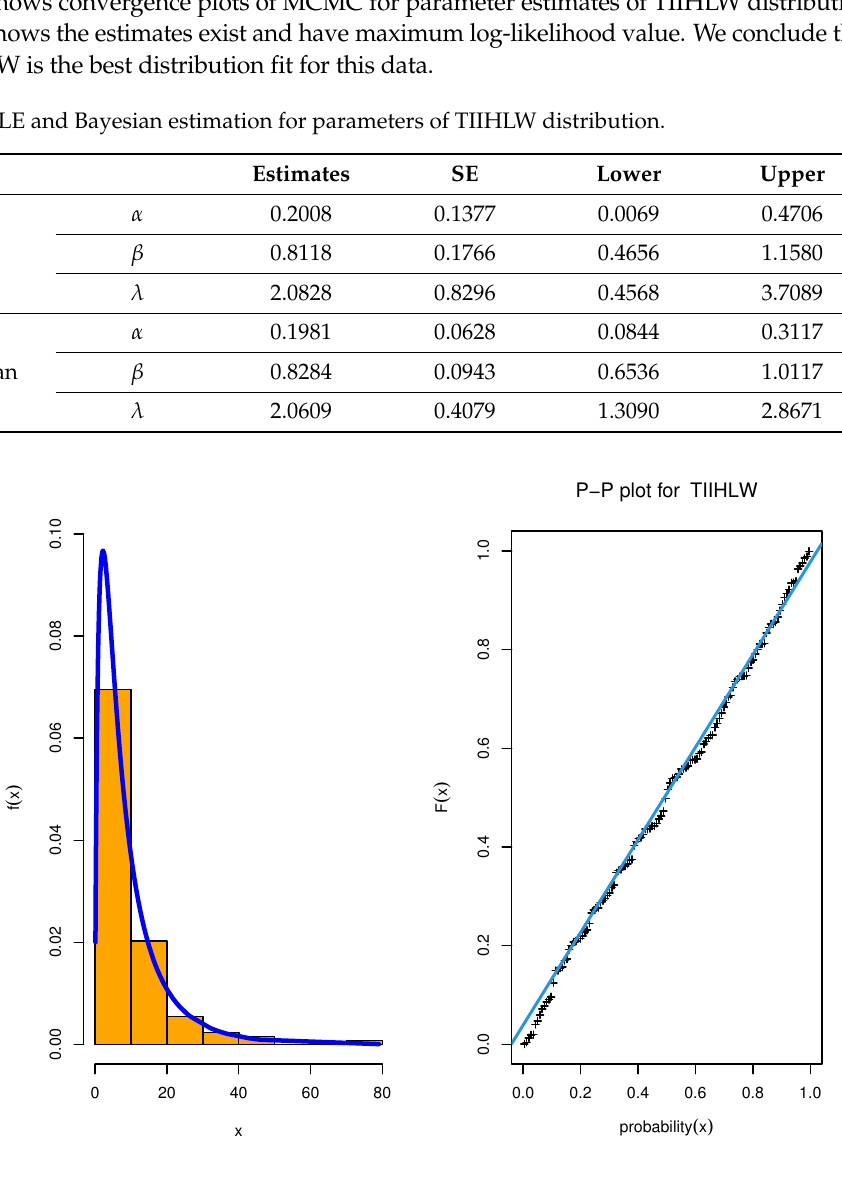
Figure 2. Estimated CDF and empirical CDF, estimated PDF with histogram, Q-Q plot, and P-P plot for the TIIHLW